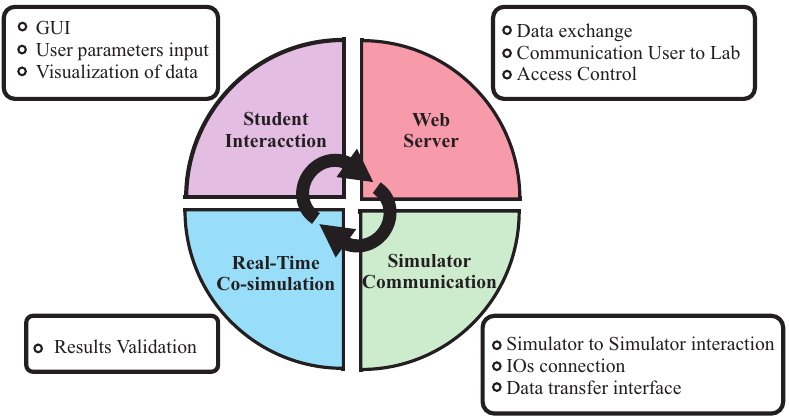
Figure 4. Framework Virtual Laboratory